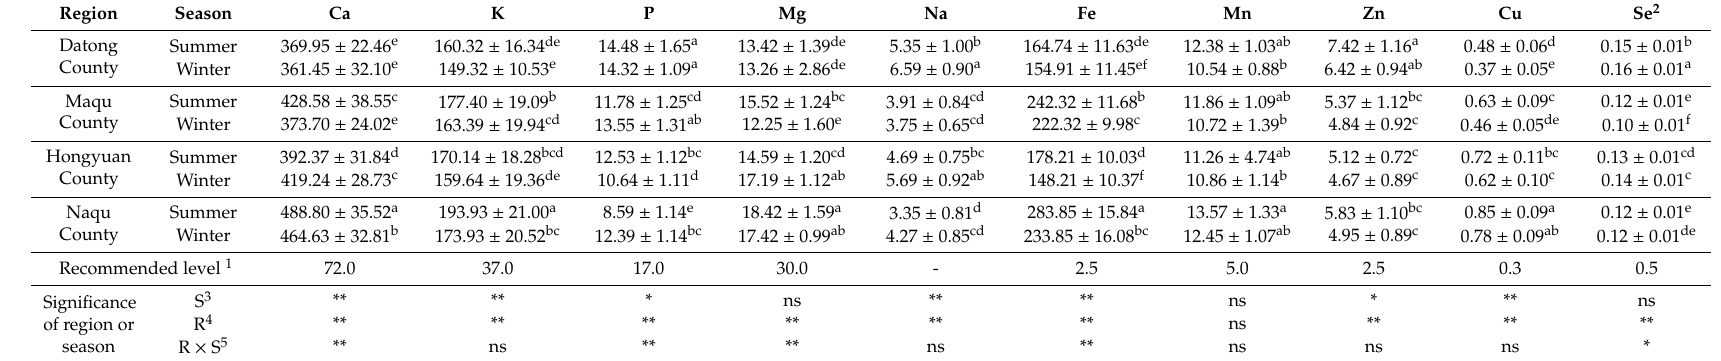
Table 2. Available concentrations (mg / kg DM) of mineral elements in soil (mean ±